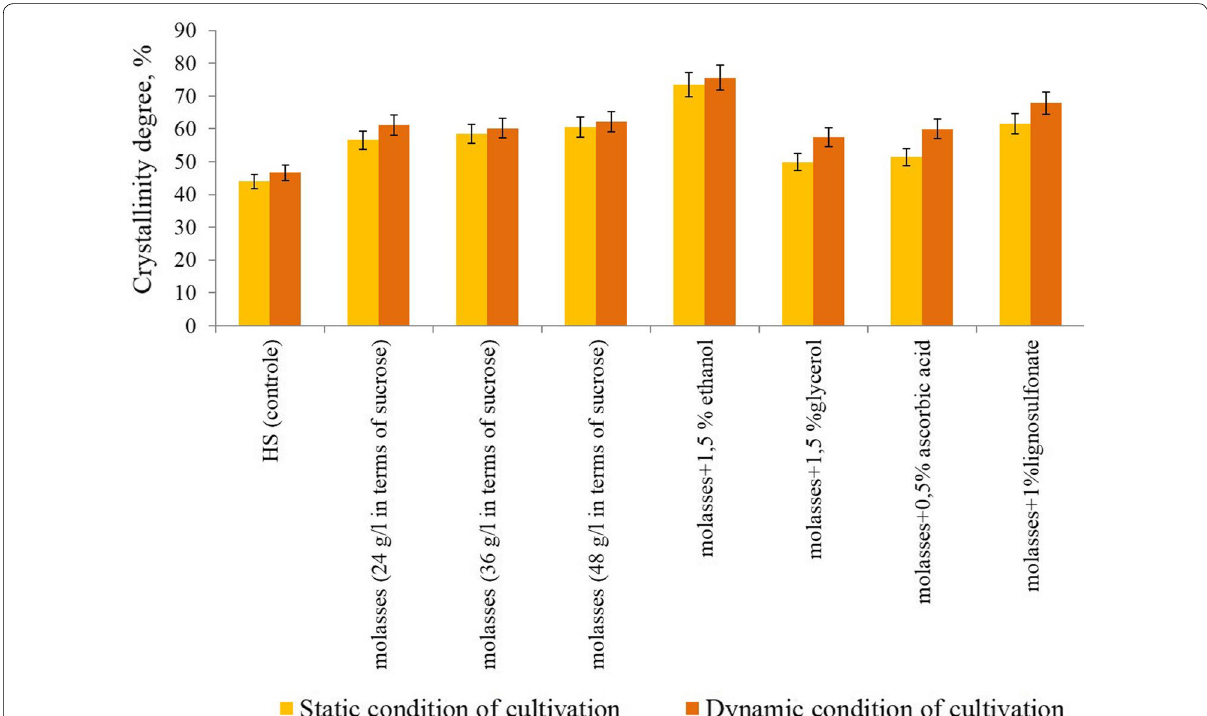
Fig. 2 Crystallinity degree of bacterial cellulose obtained in static and dynamic condition of cultivation on various